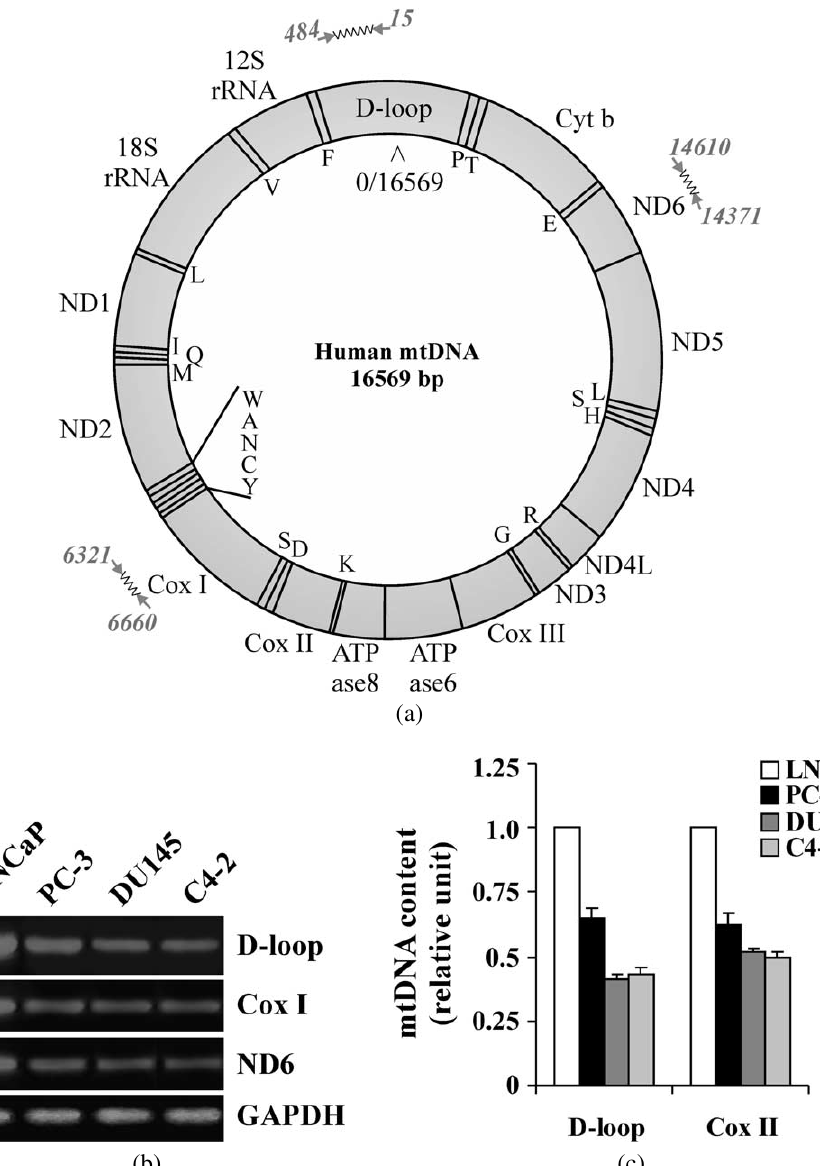
Fig. 1. mtDNA content and ΔΨ m in LNCaP and PC-3 cells. (a) Human mtDNA (16569 bp) is a double-stranded circular genome that encodes for 13 proteins of the respiratory chain, 2 rRNAs (12S and 16S) and 22 tRNAs required for intramitochondrial protein synthesis. ND1–ND6 and ND4L encode seven complex I (NADH–ubiquinone oxidoreductase) subunits, Cyt b encodes one subunit of complex III (ubiquinol:cytochrome c oxidoreductase), Cox I–Cox III encode the three major catalytic subunits of complex IV and ATPase6 and ATPase8 encode two subunits of complex V (ATP synthase). The D-loop (or control region) contains regulatory elements for mtDNA transcription and replication. Arrows indicate the primers for Cox I, ND6 and D-loop regions used to analyze the mtDNA content by PCR. (b) To analyze the mtDNA content in LNCaP, PC-3, DU145 and C4-2 cells, 10 ng total DNA/sample were subjected to PCR using primers for three different mtDNA regions, i.e. D-loop, ND6 and Cox I. Amplification products of the nuclear-encoded gene GAPDH were used as control. PCR products were analysed by 1.5% agarose gel stained with EtBr. (c) The mtDNA content was quantitated using real-time PCR. Two mtDNA markers (D-loop and Cox II) and a nuclear DNA marker ( β -actin) were used. The relative amplification of mtDNA markers in PC-3, DU145 and C4-2 versus LNCaP cells was calculated upon normalization to the reference β -actin as described in Section 2. Values are the mean ± S.E. of three independent